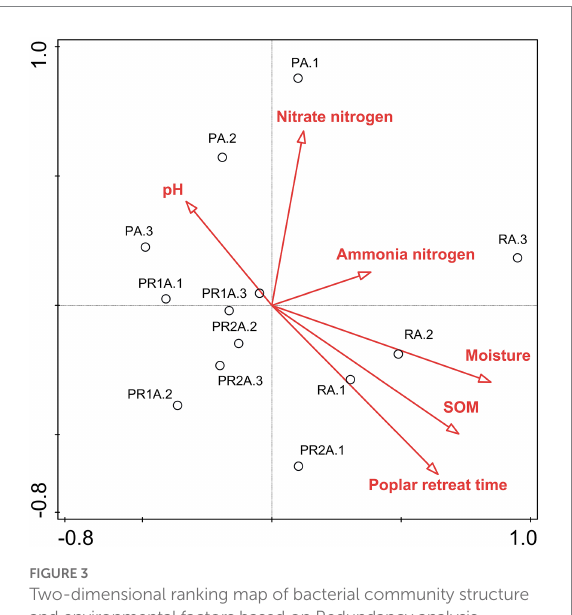
FIGURE 3 Two-dimensional ranking map of bacterial community structure and environmental factors based on Redundancy analysis. Samples are shown as circles; environmental factors are indicated by straight lines and hollow arrows. SOM: soil organic